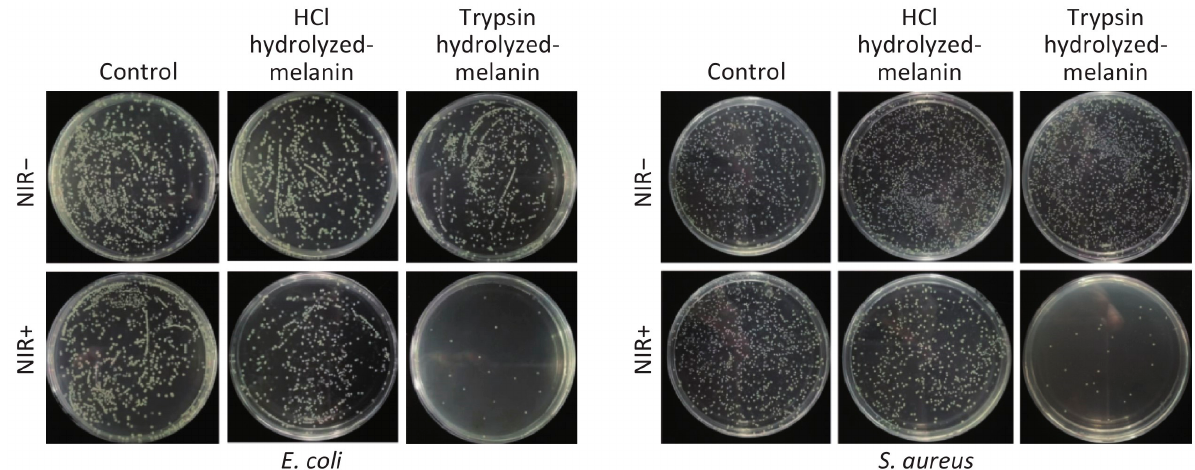
Figure 6. Escherichia coli ( E. coli ) and Staphylococcus aureus ( S. aureus ) were incubated with H-melanin and T-melanin, followed by NIR irradiation for 15 min. Photographs show E. coli and S. aureus after incubation with melanin, followed by NIR irradiation. Reprinted with permission from Ref. [177]. Copyright 2020 Elsevier.